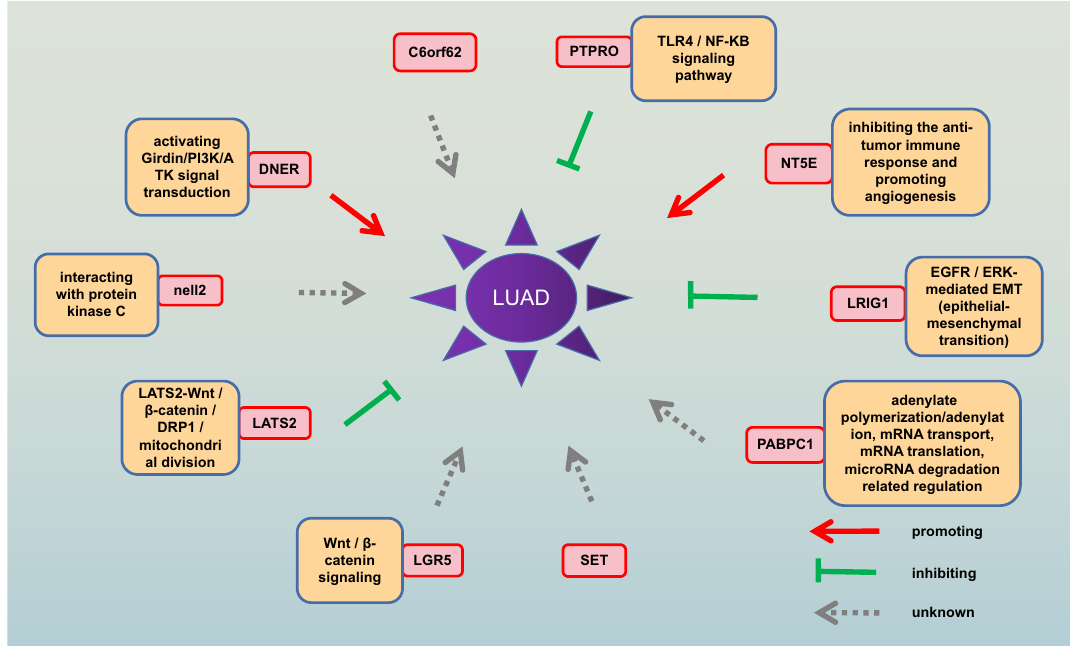
Figure 10. Schematic diagram. The schematic diagram was drawn to reflect the genes in the signature how to guide the progression of LUAD. The red arrow represented promoting the progression of LUAD, the green arrow represented inhibiting the progression of LUAD, and the gray arrow represented the impact on LUAD not